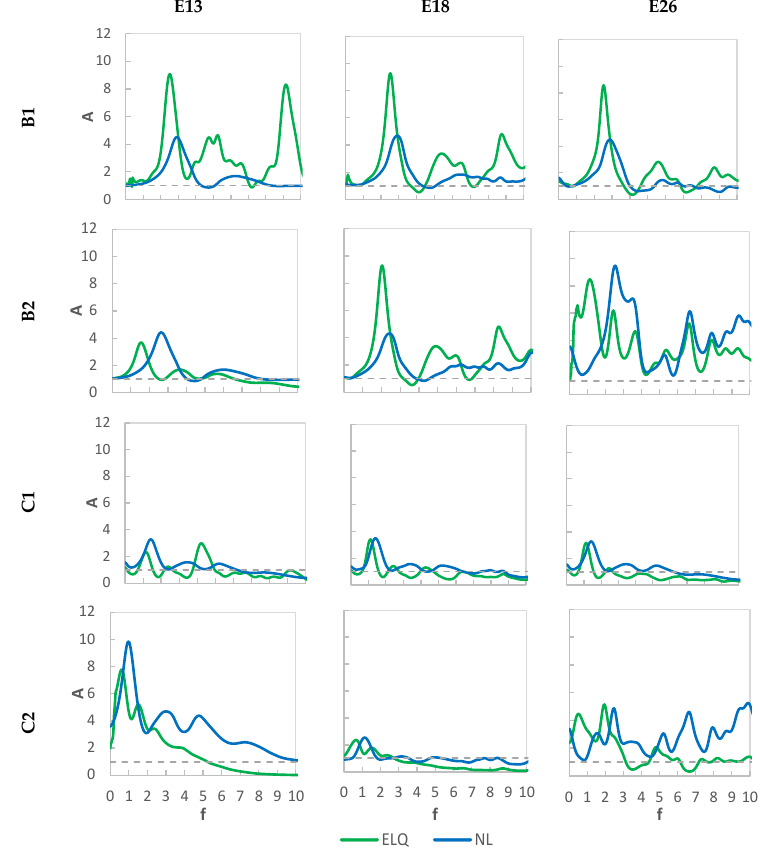
Figure 20. Comparison between the amplification functions in the SS alignment for the two different constitutive models (ELQ vs. NL).